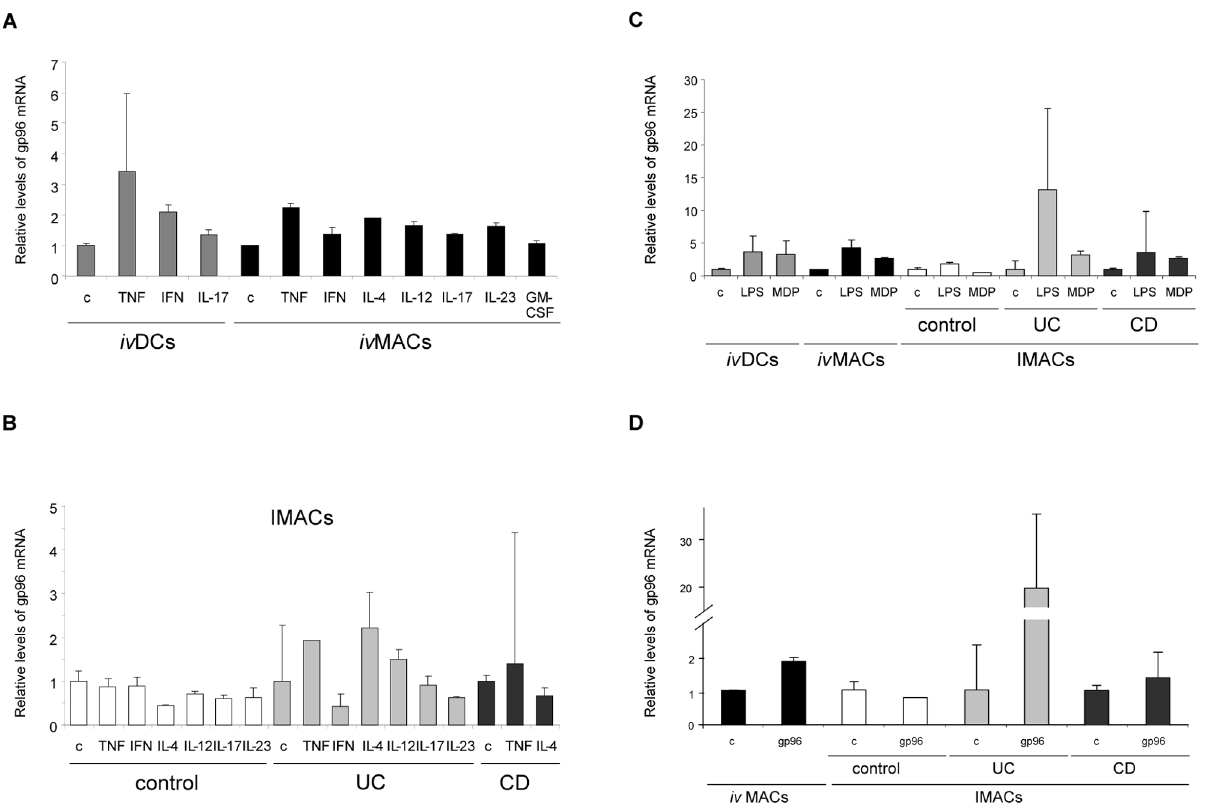
Figure 3. Stimulus-dependent expression of gp96 mRNA in human innate immune cells. Relative mRNA levels of gp96 are shown (vs. GAPDH/ b -actin) in i. v.DCs, i. v.MACs and IMACs from control, UC, and CD patients. Cells were stimulated for 2 h. Results are representative for three experiments. Error bars represent the standard deviation of a single experiment measured in triplicate. (A) Stimulation of i. v.DCs and i. v.MACs with cytokines. (B) Stimulation of IMACs with cytokines. (C) Stimulation of i. v.DCs, i. v.MACs and IMACs with bacterial envelope components. (D) Stimulation of i. v.MACs and IMACs with gp96 protein. c: unstimulated control; TNF: tumour necrosis factor, IFN- c : interferon-gamma, IL: interleukin IL-12, IL-17, IL- 23 (100 ng/mL each); GM-CSF: granulocyte-macrophage-colony stimulating factor (50 ng/mL); IL-4 (5 ng/mL); LPS: lipopolysaccharide, MDP: muramyl-dipeptide (10 ng/mL each); gp96: glycoprotein 96 (10 m g/mL).